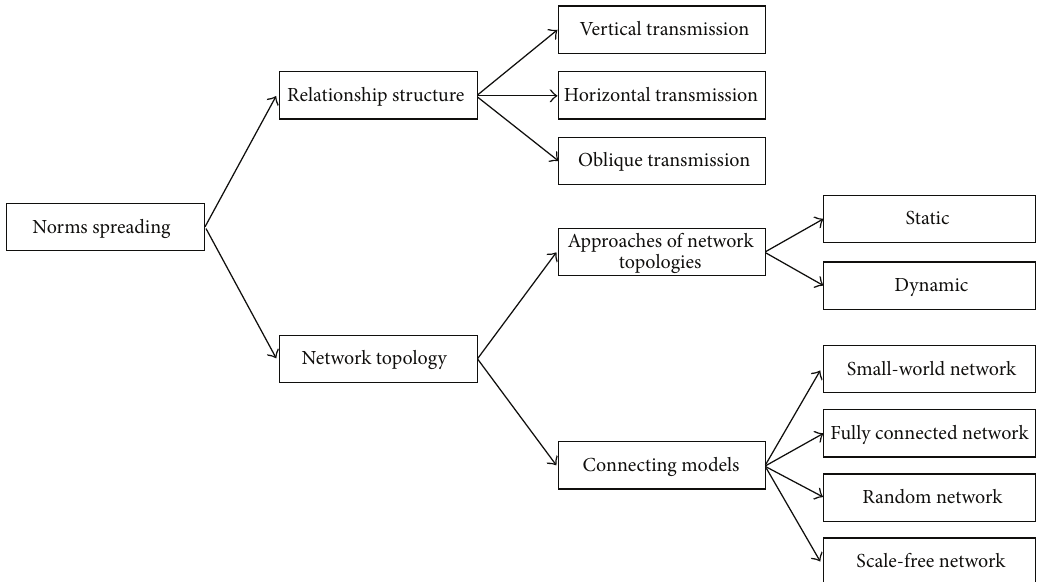
Figure 8: Norms spreading relationships and network